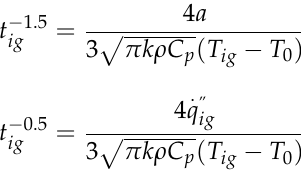
Figure 5. Sample heat transfer progress under rising heat flux [56].